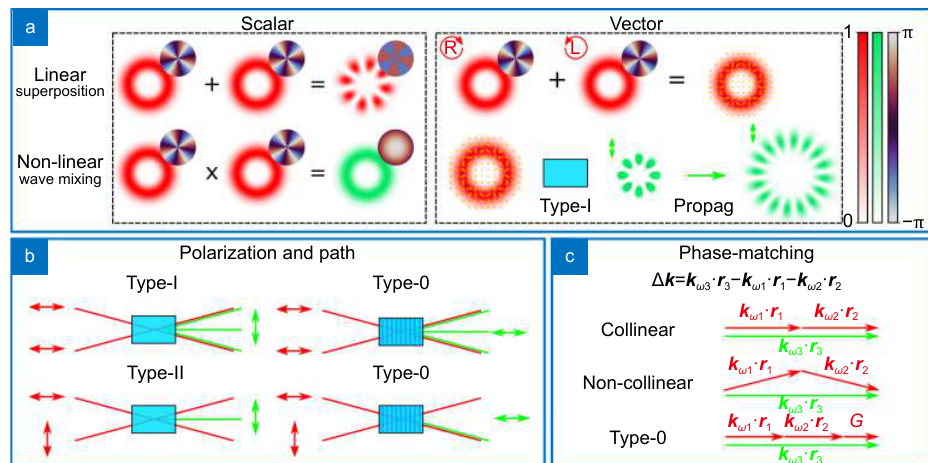
Fig. 1 | Linear and nonlinear processes. Using second harmonic generation (SHG), we illustrate the differences between linear and nonlinear processes. ( a ) Linear processes produce an output mode that is the addition of two input spatial modes of light, while SHG produces the product of the two modes. The linear superposition of two different modes with orthogonal polarization states generates a vector beam, which has a in- homogeneous polarization state. The polarization profile is represented as yellow lines across the transverse profile. In SHG, and wave mixing in general, the polarization profile will dictate where wave mixing happens and thus alter directly the spatial profile. In ( b ) we show exemplify how path can also be controlled via polarization and the different phase matching conditions of crystals, including the periodic poling of type-0. The mechanism which allows these interactions is sketched in ( c ). Phase-matching is the condition necessary for wave mixing to occur and exploits birefringence (types I and II) or periodical polling (type-0) to achieve